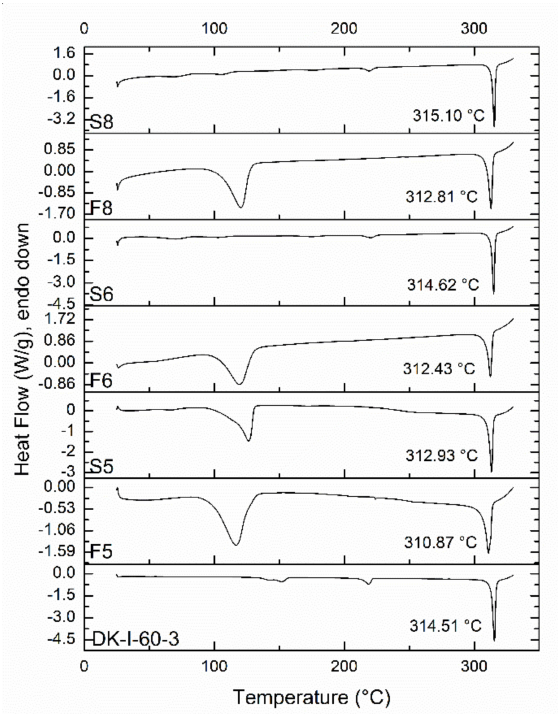
Figure 4. DSC thermograms of unprocessed DK-I-60-3, nanocrystal dispersions (F5, F6, and F8), and corresponding suspensions (S5, S6, and